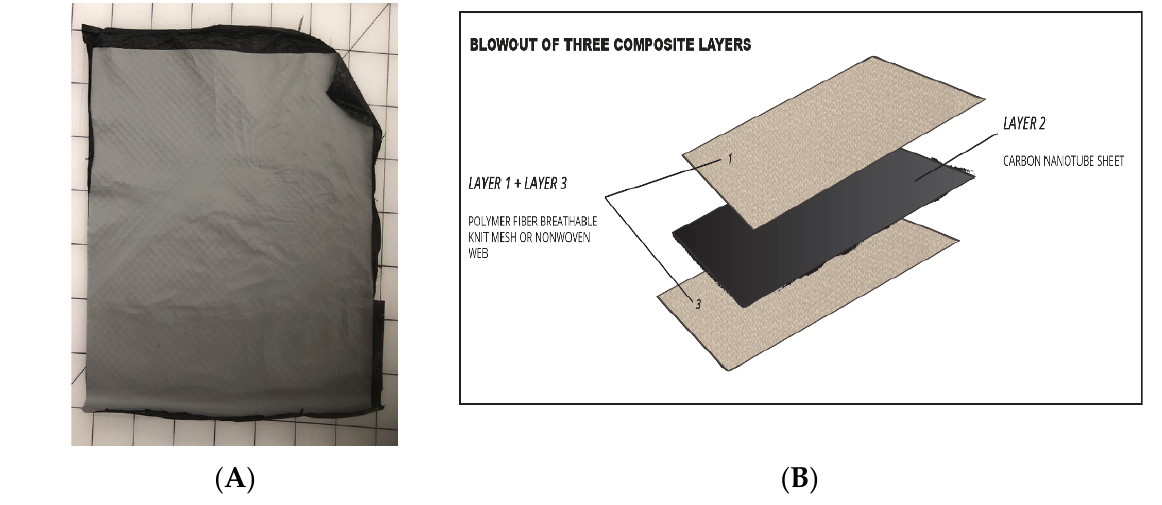
Figure 3. ( A ) Pristine CNT laminated; ( B ) layout for a three layer composite.